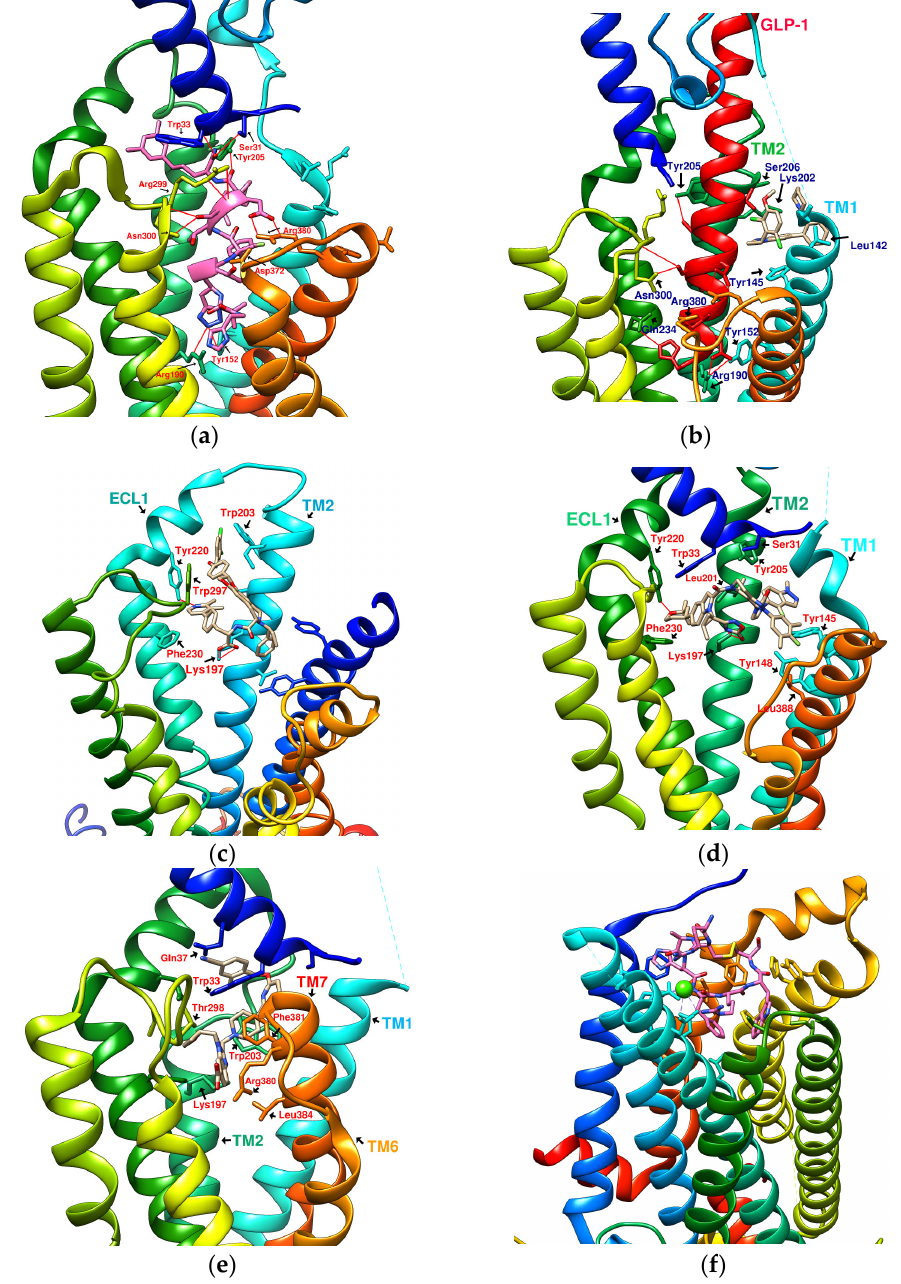
Figure 3. Reference GLP-1R and MC4 (GPCR) complex (PDB file from RCSB Protein Data Bank). ( a ) Peptide 5/GLP-1R (PDB:5NX2); ( b ) LSN3160440 and GLP-1 in GLP-1R (PDB:6VCB); ( c ) TT- OAD2/GLP-1R (PDB:6ORV); ( d ) LY3502970 in GLP-1R (PDB:6XOX); ( e ) PF-06882961/GLP-1R (PDB:6X1A); ( f ) Setmelanotide/MC4R (PDB:7PIU).